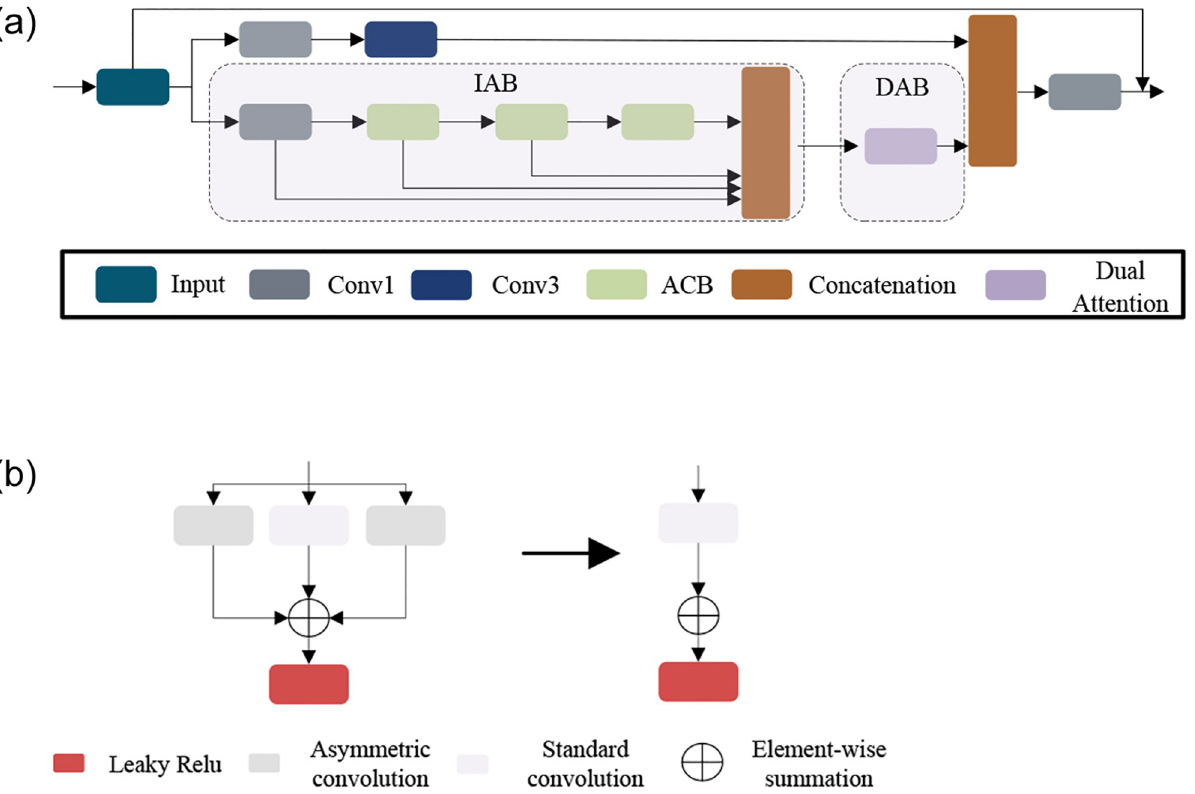
Fig 2. (a) The structure of our proposed MFAB. MFAB contains IAB and DAB. (b) The structure of ACB. ACB transforms to standard convolution in the inference stage.